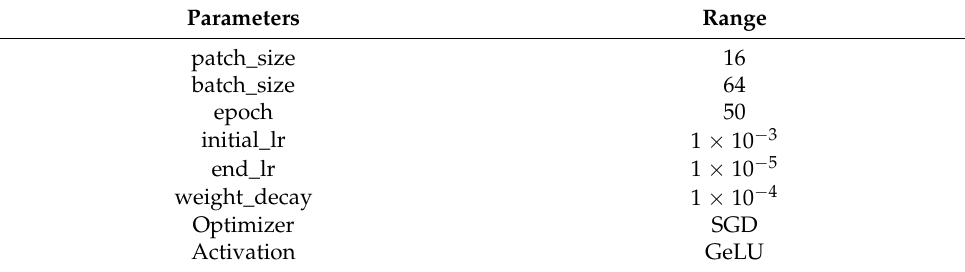
Table 1. Parameter values in